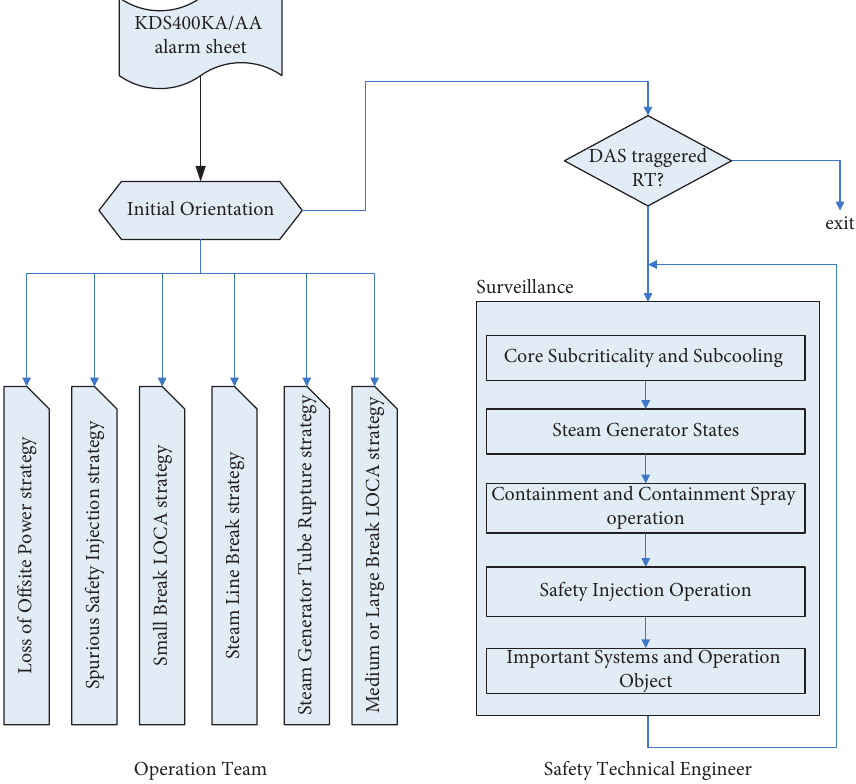
Figure 4: Emergency operating strategies on